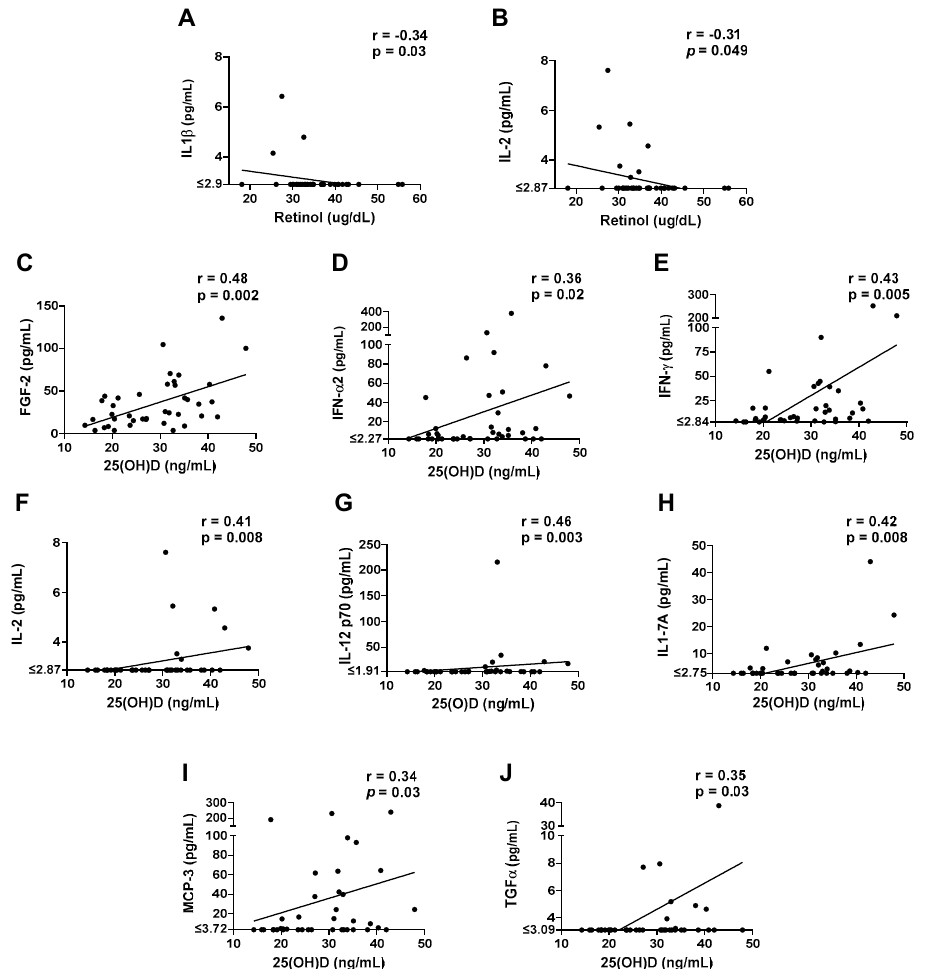
Figure 6. Vitamin and cytokine/chemokine levels. Significant correlations are shown between cytokine/chemokine ( A , B ) and retinol ( C – J ) or 25(OH)D levels. Each symbol represents a different individual. Spearman correlation test results are shown.